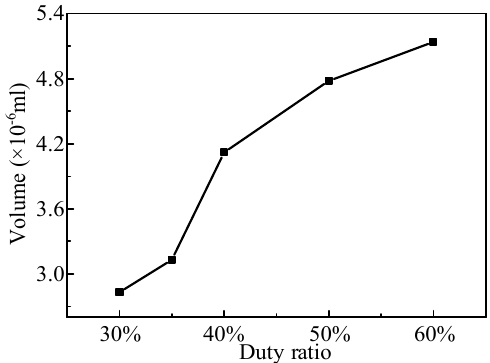
Figure 20. The relationship between single droplet’s volume and the duty ratio.